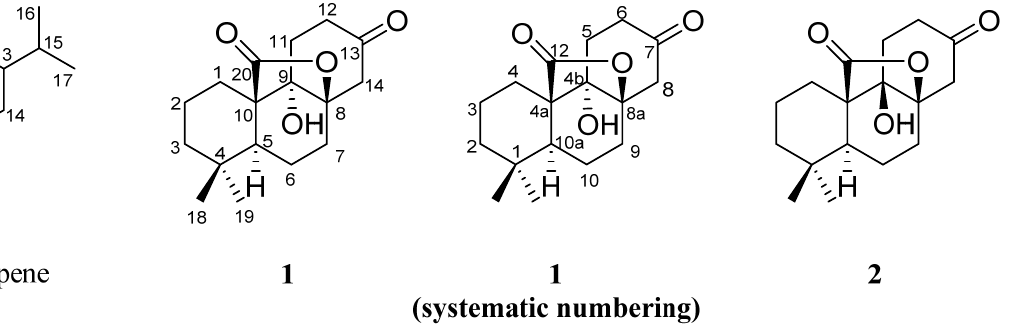
Figure 1. The structures of abietane diterpene and compounds 1 and 2 .